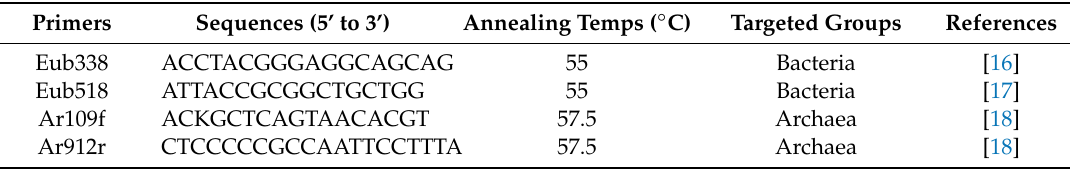
Table 2. The qPCR primers and conditions used in this